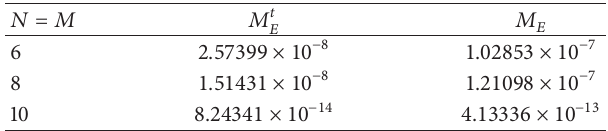
Table 3: Maximum absolute errors for problem (46) for 𝑇 = 1 and